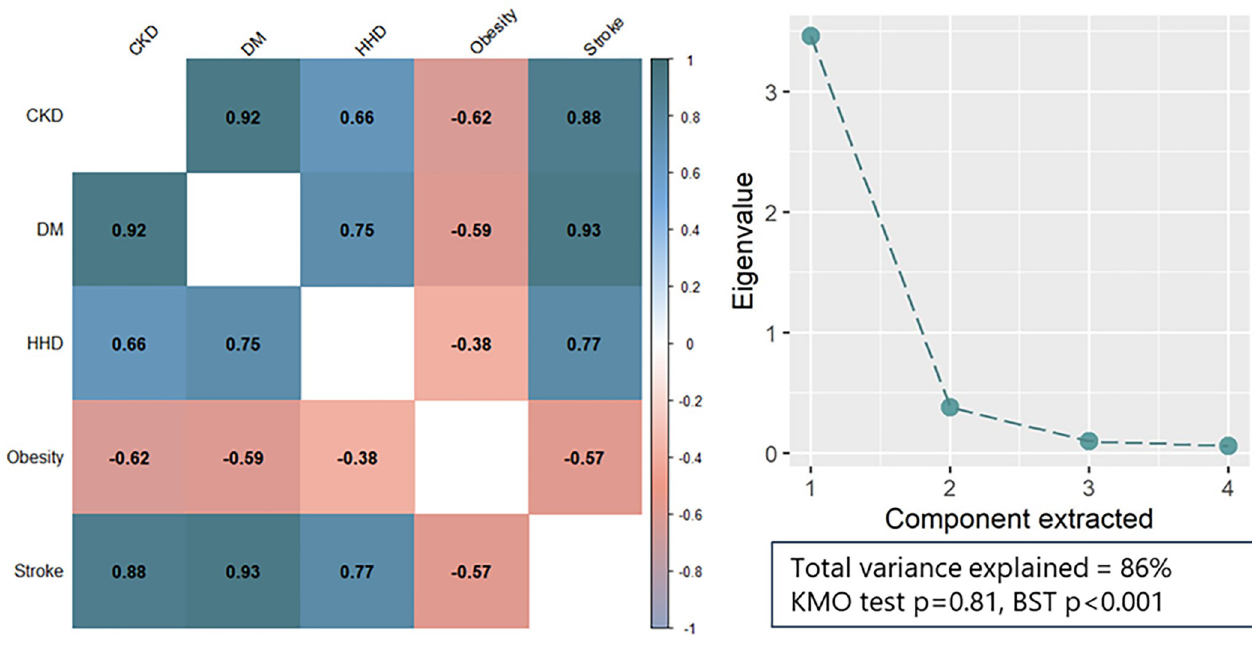
Fig 4. Correlation matrix for covariates tabulated in the analysis (left) and principal components analysis results (right). Scree plot (right) for total variance explained for included variables in principal components analysis (CKD, Diabetes, Stroke, HHD). CKD, Chronic Kidney Disease. DM, Diabetes mellitus. HHD, Hypertensive Heart Disease, HIV, Human Immunodeficiency Virus. KMO, Kaiser-Meyer-Olkin test. BST, Bartlett’s Sphericity Test.